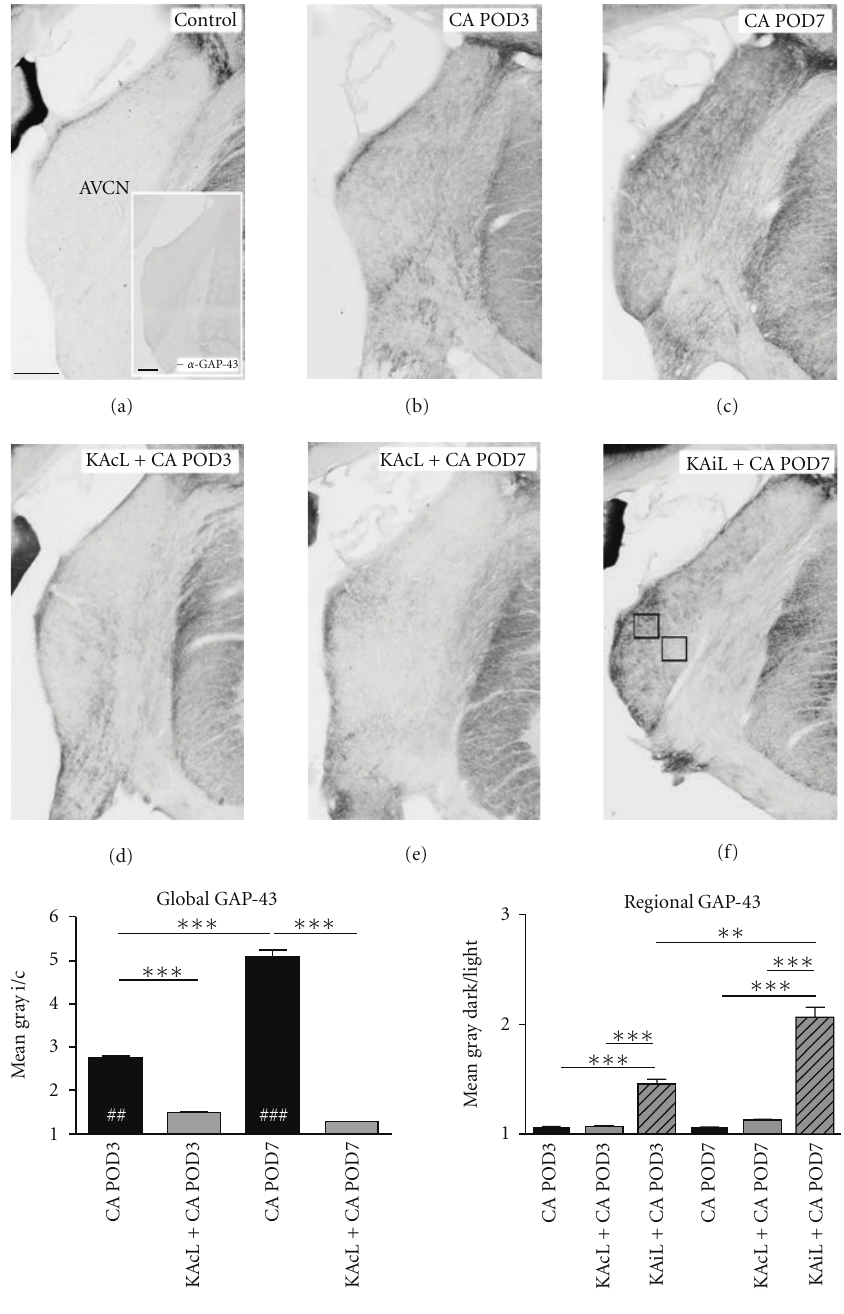
Figure 4: GAP-43 expression in AVCN after complete or incomplete VNTB lesion and subsequent cochlear ablation. (a) Little GAP-43 expression was found in AVCN of control animals. Inset: no staining occurred when omitting the primary antibody. (b, c) Following cochlear ablation, GAP-43 staining emerged around POD3 (b) and reached maximal intensity by POD7 (c). (d, e) Combining complete lesion of VNTB with cochlear ablation (KAcL + CA) led to near-complete failure of GAP-43 expression in AVCN. (f) In cases with incomplete lesion (KAiL + CA) of VNTB, GAP-43 staining failed only locally, producing a patchy staining in AVCN. Frames indicate test fields for quantitative analysis of local GAP-43 staining density. Scale bar in (a)–(f), including inset in (a) 200 μ m. Global contrast adjustments are identical for all photographs shown. (g) Staining intensity of GAP-43 immunoreactivity in the AVCN given as gray tone mean. Bars indicate ipsilateral- to-contralateral ratio (i/c) for cases with CA alone and KAcL + CA at POD3 and POD7 following cochlear ablation. Asterisks indicate significant di ff erences among groups, number signs (hash symbols) indicate significant di ff erences against control. (h) Heterogeneity of GAP-43 staining in ipsilateral AVCN after CA, KAcL + CA, and KAiL + CA. Bars indicate ratio between the strongest and faintest GAP-43- stained region within the